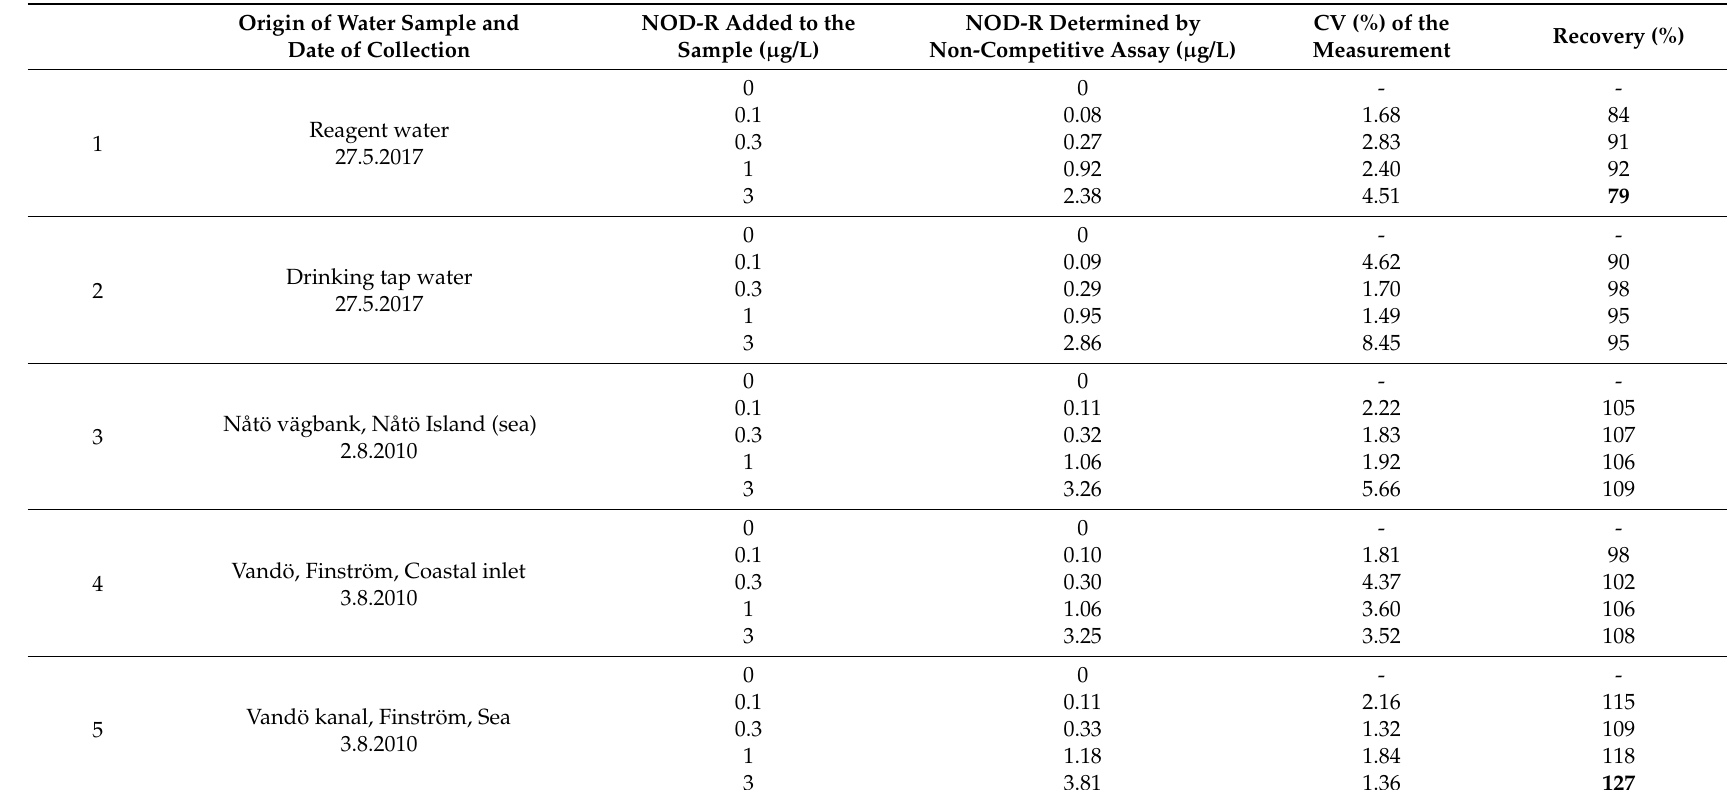
Table 2. The performance of non-competitive assay with NOD-R spiked water